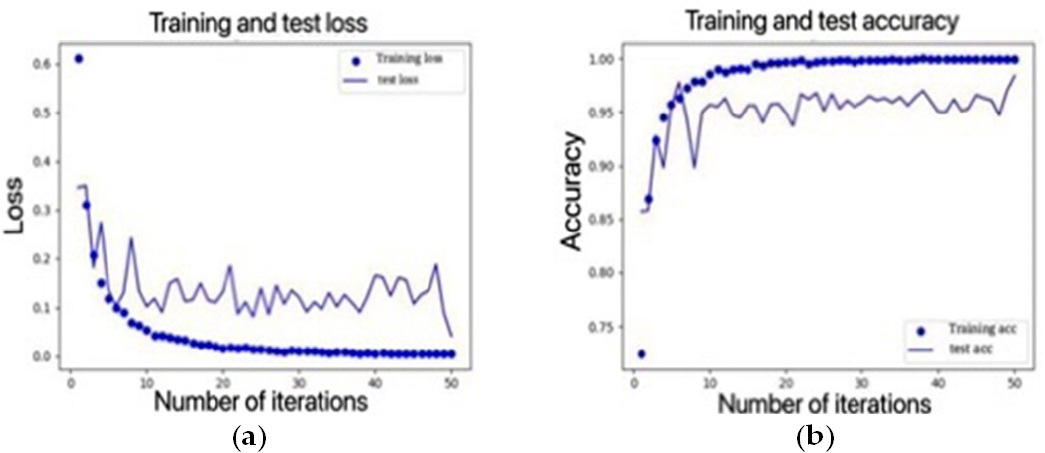
Figure 9. AgriEngineering 2020 , 3 FOR PEER REVIEW